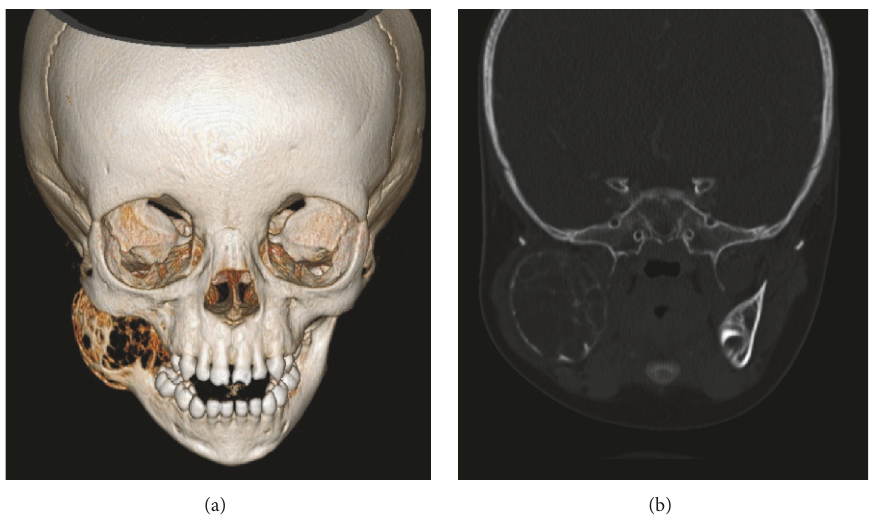
Figure 2: 3D CT scan showing ballooning expansion of cortex.